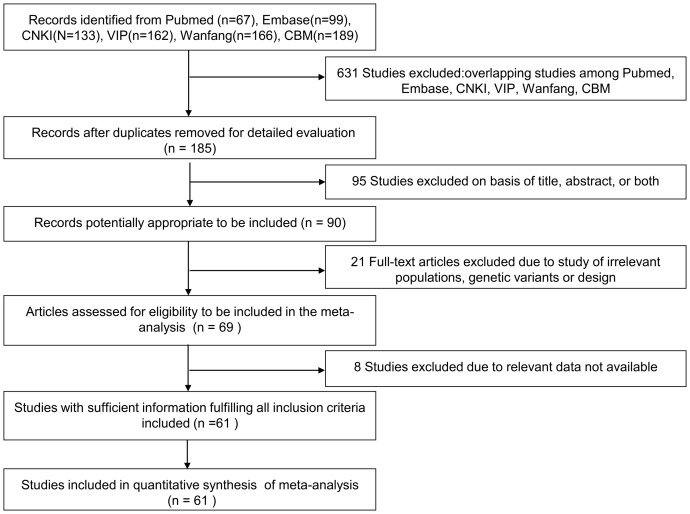
The flowchart of selection of studies.